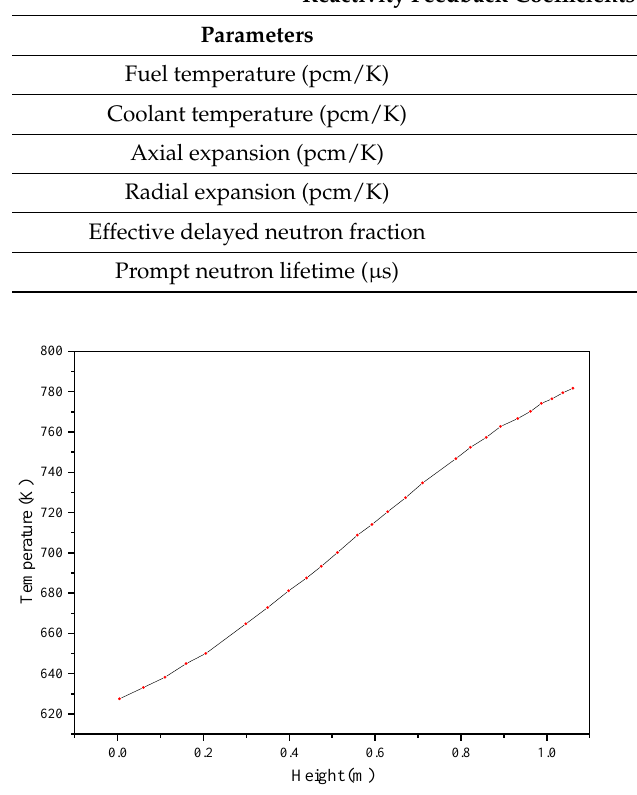
Figure 3. Coolant temperature rise.